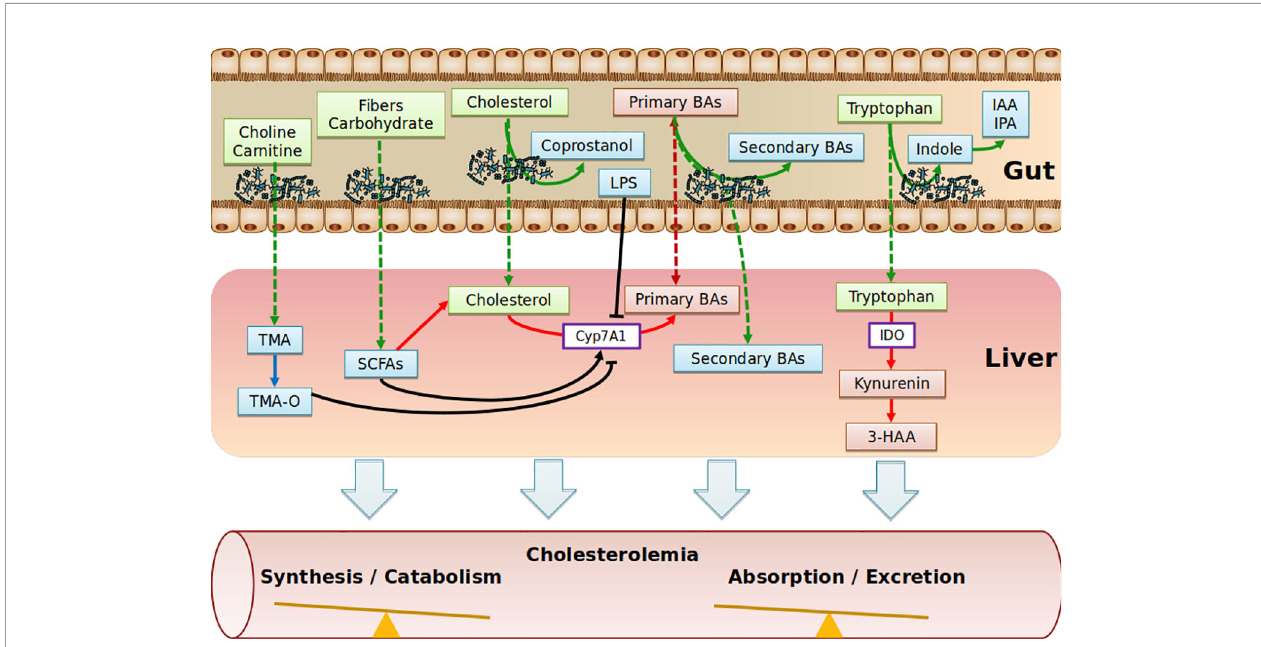
FIGURE 2 | Schematic depicting the range of putative pathways through which the gut metabolites impact on cholesterol metabolism. Diet nutriments (green boxes) are metabolized and transformed into microbial metabolites (blue boxes) by gut microbiota. Purple boxes represent enzymes. Red boxes represent host metabolites. TMA, Trimethylamine; TMA-O, Trimethylamine-Oxide; SCFAs, Short Chain Fatty Acids; BAs, Bile Acids; IAA, Indole-3-acetic acid; IPA, Indole-3-propionic acid; IDO, indoleamine2,3-dioxygenase; 3-HAA, 3-hydroxyanthranilic; LPS,